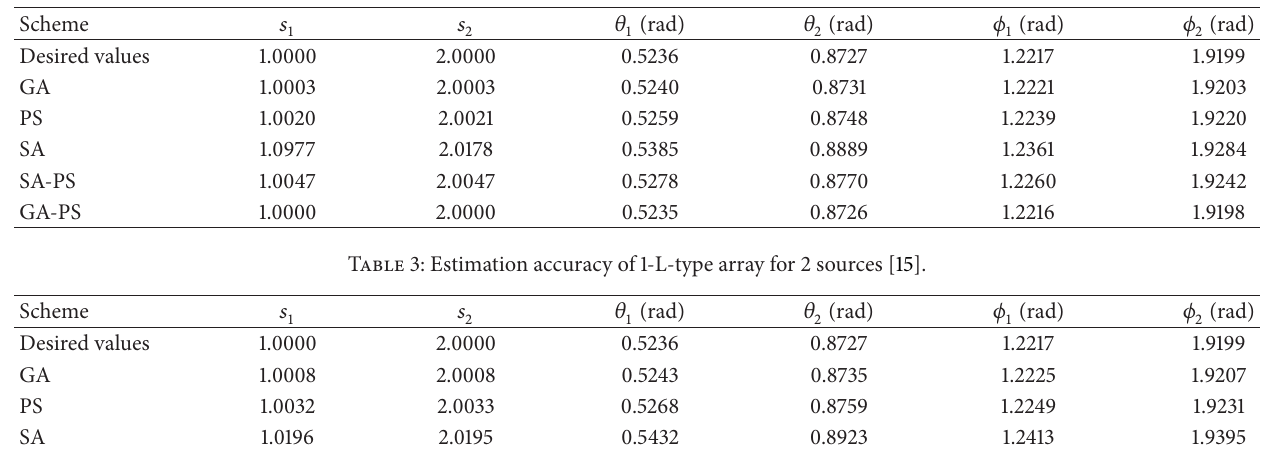
Table 2: Estimation accuracy of 2-L-shape array for 2 sources.